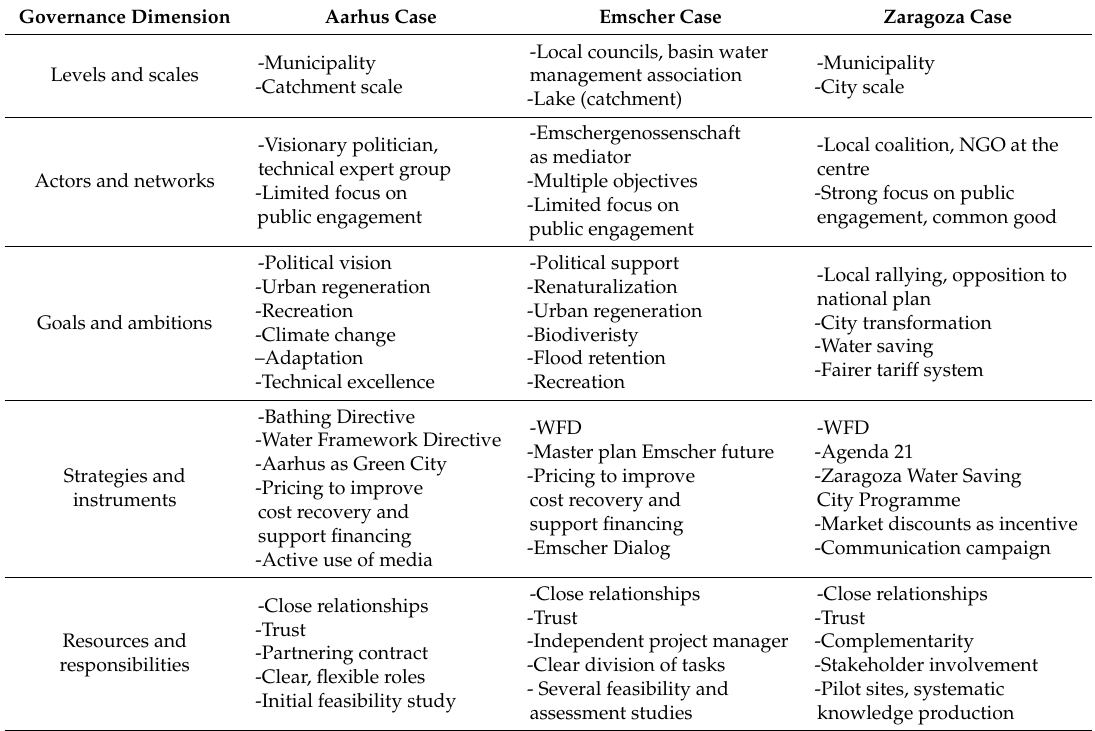
Table 3. Key results of each case study on each dimension of the governance assessment